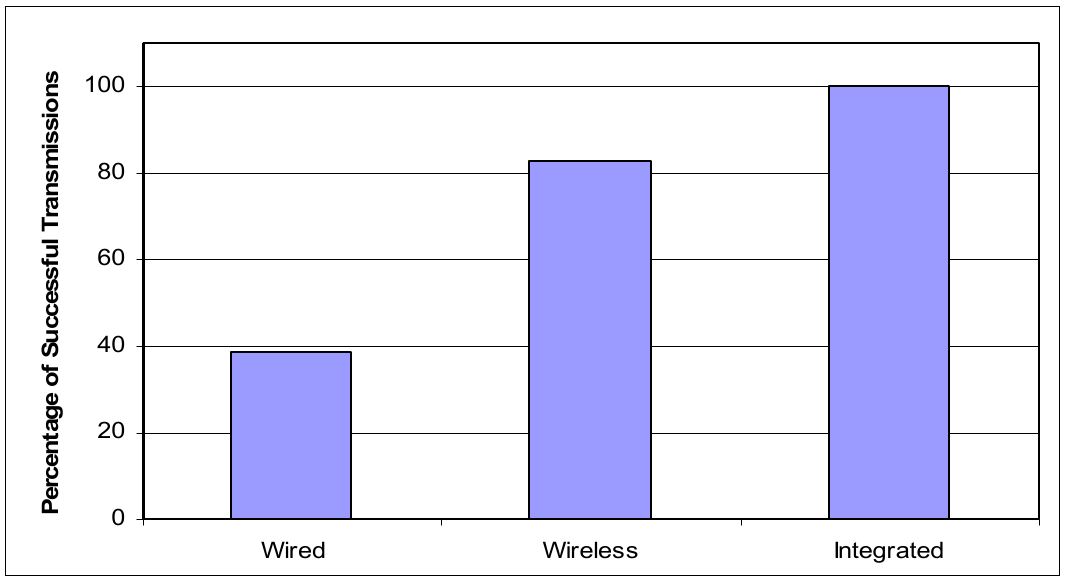
Figure 8. Transmission reliability for different architecture scenarios.